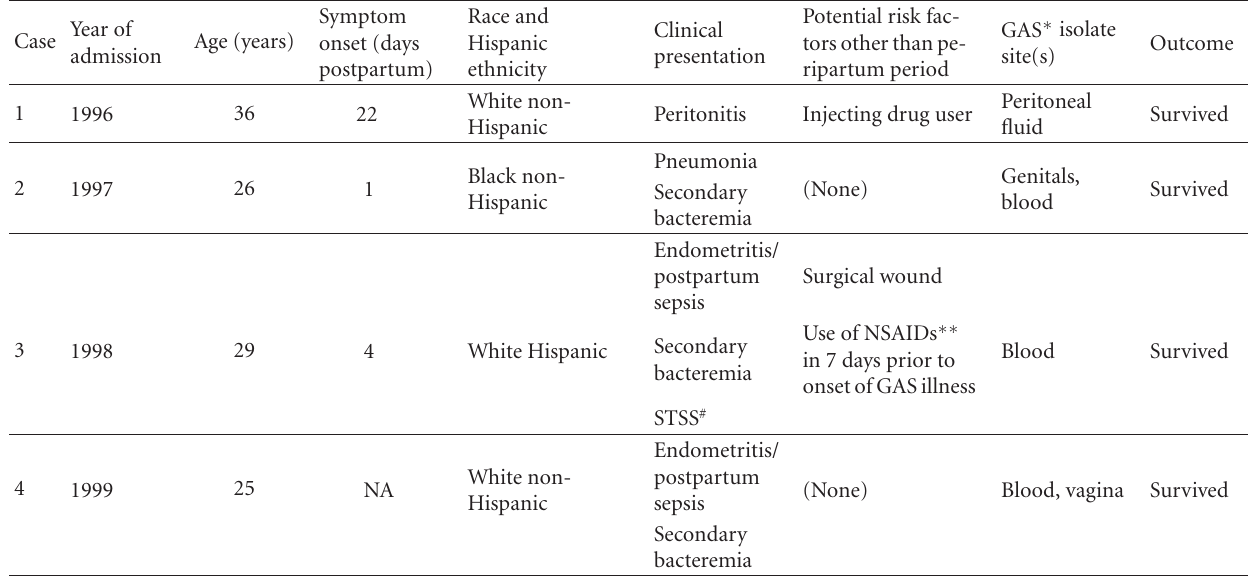
Table 1: Clinical, laboratory, and epidemiologic characteristics of postpartum invasive group A streptococcal